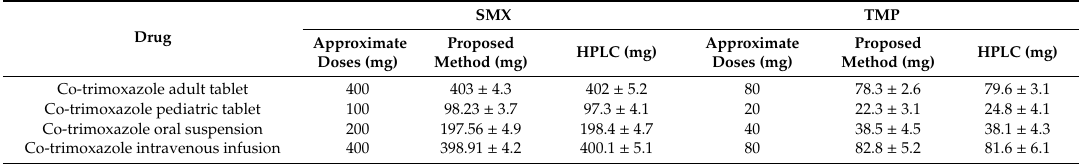
Table 3. Results of the replicate measurements ( n = 3) for the determination of SMX and TMP in some pharmaceutical formulations.